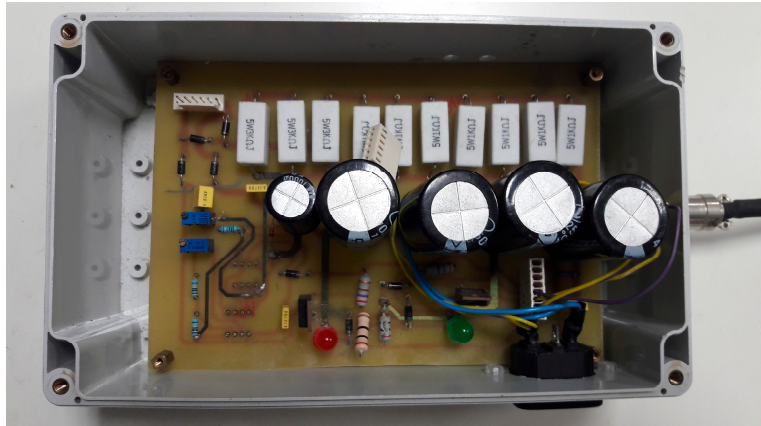
Figure 3. Experimental setup of the circuits.